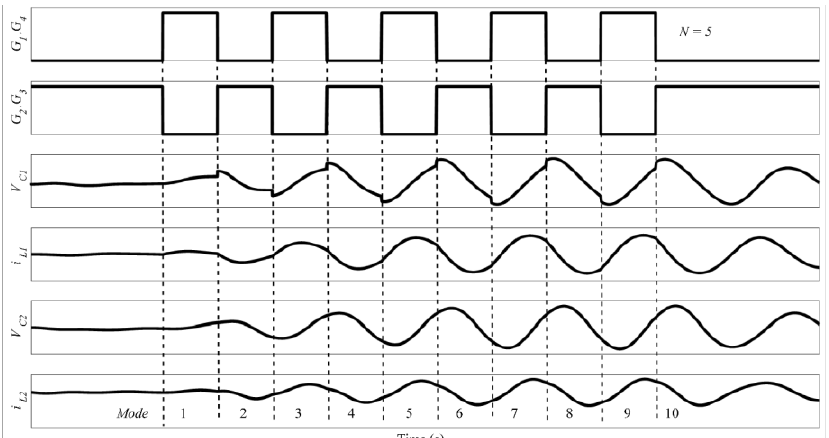
Figure 6. Relevant voltage and current operating waveforms.